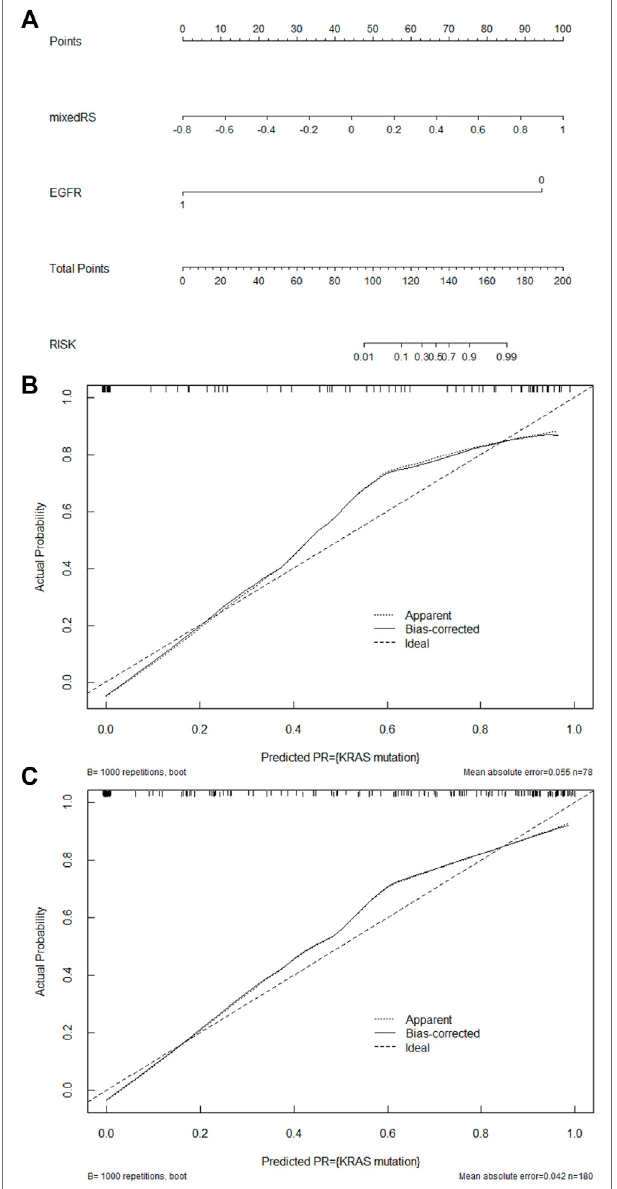
FIGURE 4 | Development and performance of a nomogram. (A) Nomogram establishment by integrating mixedRS and EGFR. Nomogram calibration curves in the training (B) and validation (C) cohorts. The diagonal dashed line represents a predicted value equal to the true value, and the solid line is the model ’ s prediction of KRAS mutation. The closer the two lines are, the better the performance.